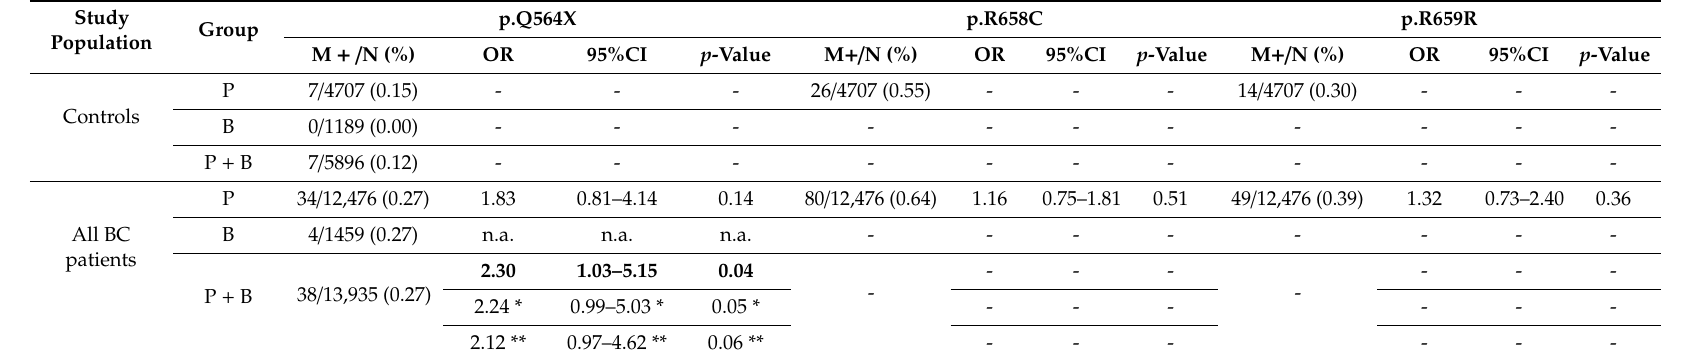
Table 2. The frequencies and e ff ect sizes of the three tested BARD1